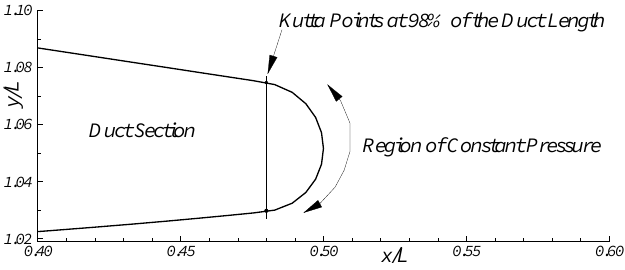
Figure 3. Pressure Kutta condition for the duct trailing edge with a thick round geometry and L denoting the duct